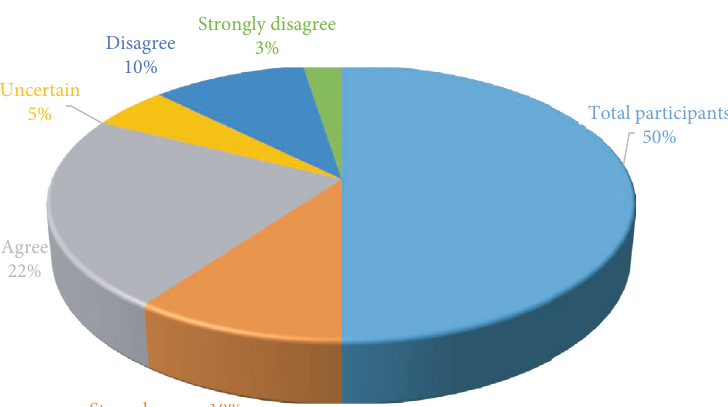
Figure 18: Feasibility report of the blockchain-based land registry